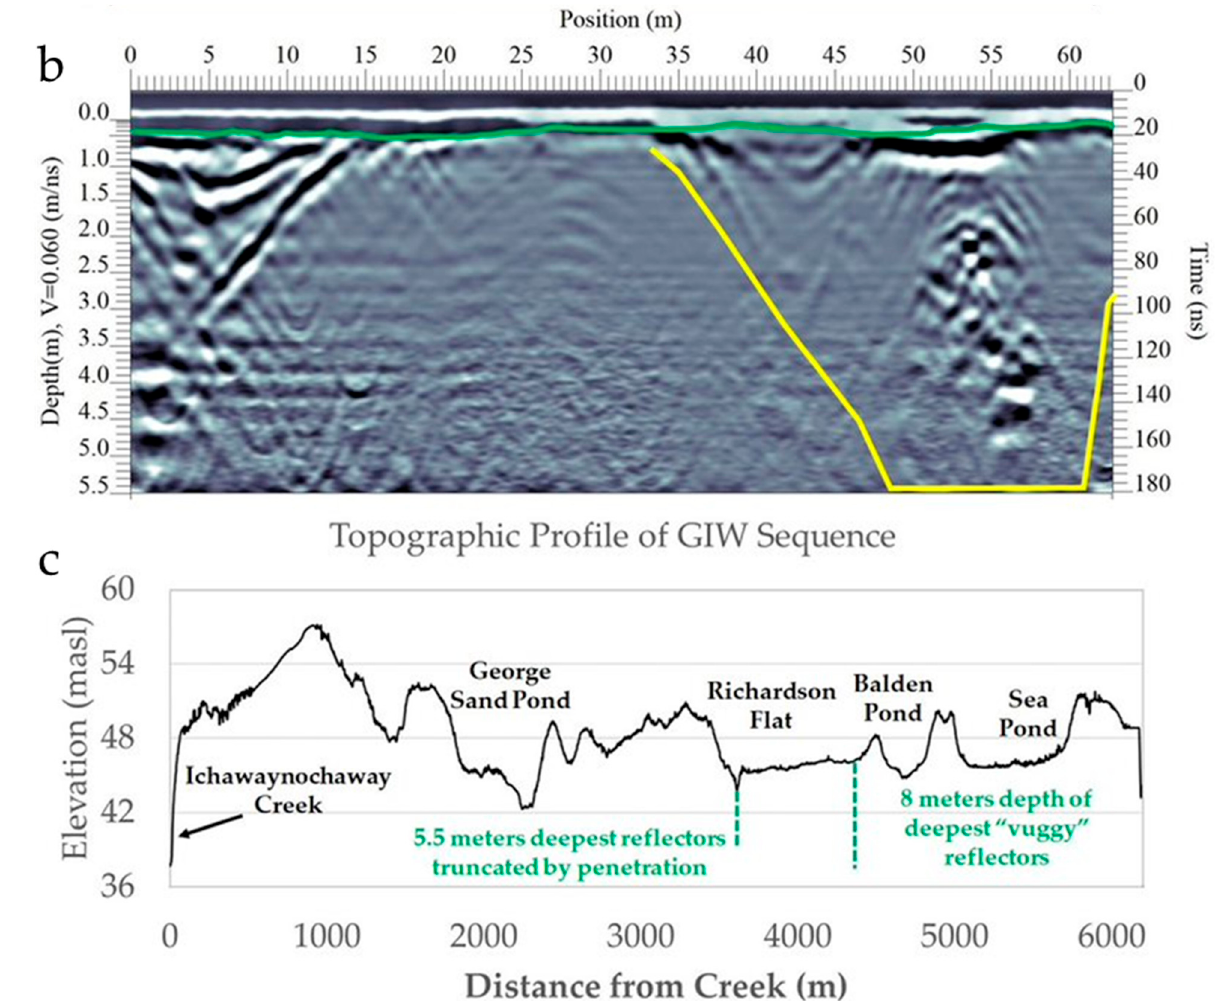
Figure 3. ( a ) GPR survey along the road separating Richardson Flat and Balden Pond. The left side of the image is the north end of the survey. The green line is the top of the soil. The yellow and purple lines outline areas of reflectors indicative of vuggy porosity indicated by weak (yellow) and strong (purple) reflectors; ( b ) select GPR image of the high-density grid over the sink point in Richardson Flat showing a high porosity zone, outlined in yellow. These images are normalized to depth. The feature is funnel-shaped and located below the lowest point of the pond; ( c ) cross-section showing topography and depths of features.